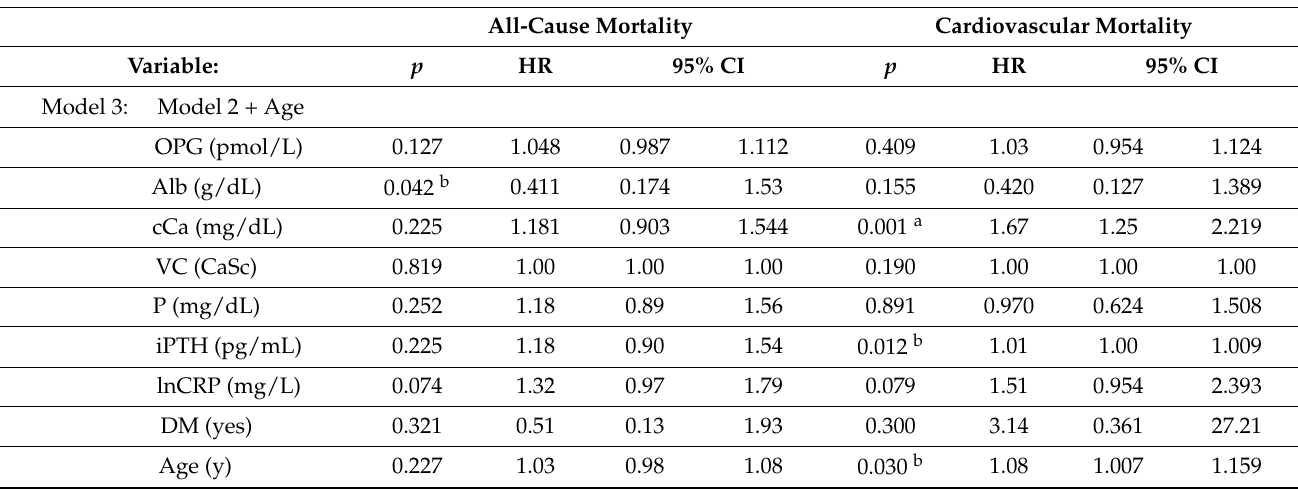
Table 5. Cont . Multivariate Cox Regression Analysis